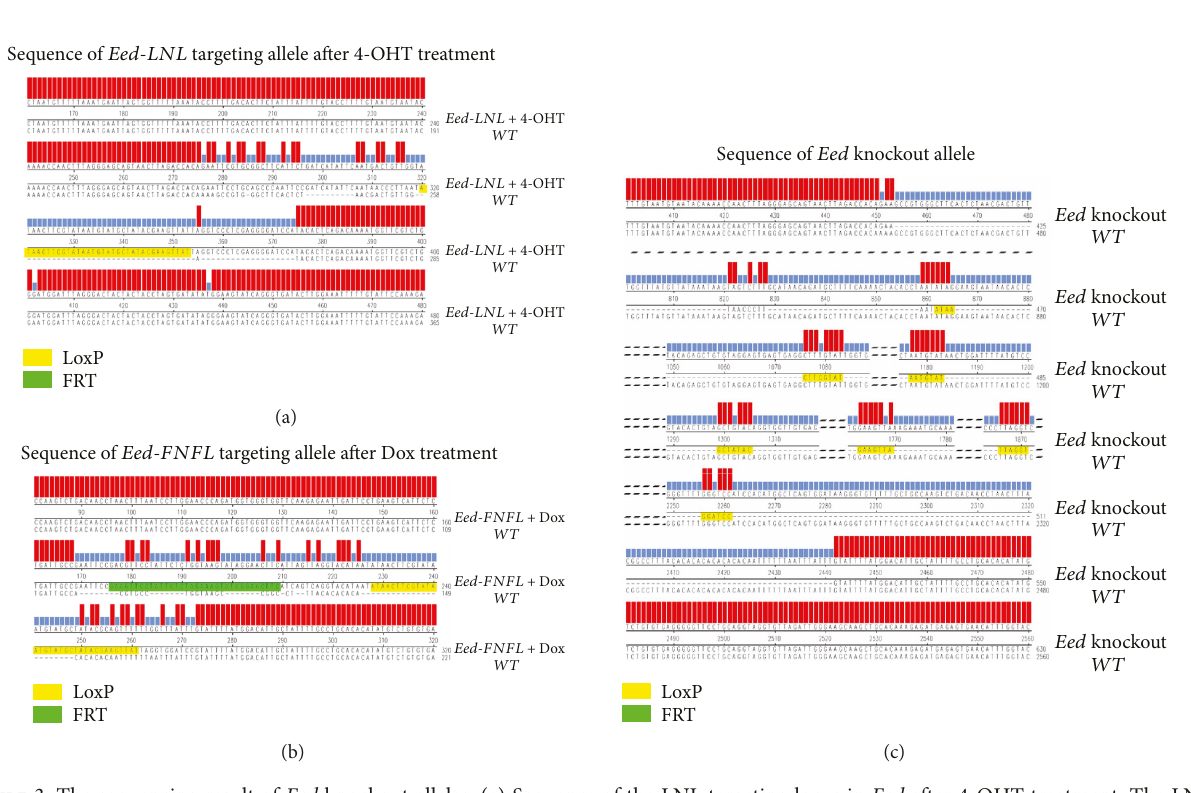
Figure 3: The sequencing result of Eed knockout alleles. (a) Sequence of the LNL targeting locus in Eed after 4-OHT treatment. The LNL cassette was deleted by 4-OHT-inducible Cre-LoxP recombination, with one LoxP site being left. (b) Sequence of the FNFL targeting locus in Eed after Dox treatment. The FNFL cassette was deleted with one LoxP site and one FRT site being left. (c) Sequence of the Eed knockout allele generated by 4-OHT-inducible Cre-LoxP recombination. The LoxP site and FRT site are indicated by yellow and green boxes, respectively. The sequence alignment was analyzed by DNASTAR software. The additional mismatched nucleotides are the spacer between the LoxP/FRT site and the restriction endonuclease cut site used for homology arm construction as well as the spacer between LoxP and FRT sites in the FNFL